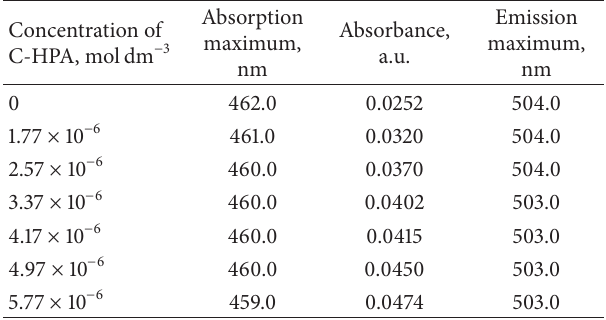
Table 4: Absorption and fluorescence spectral data of C334 with various amounts of